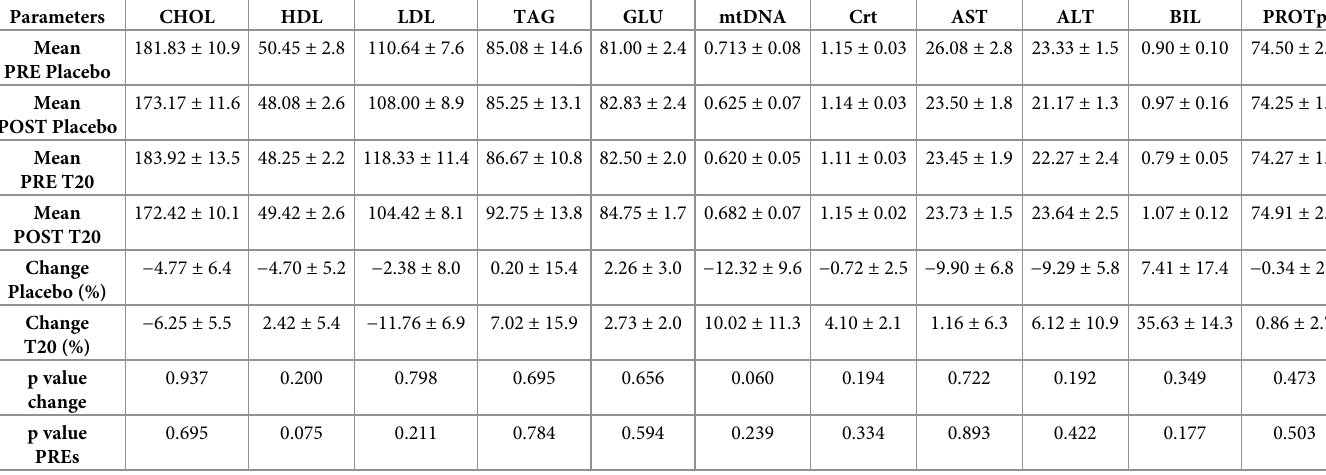
Table 1. Enfuvirtide (T20 Wilcoxon test results). n = 12 Volunteers; all men; mean age 29.2 ± 1.27. Significance was calculated among absolute values. "p value of change" represents the significance between endpoints after Phase 1 and Phase 2. "p value PREs" represents significance between values in basal circumstances. No changes were significant.